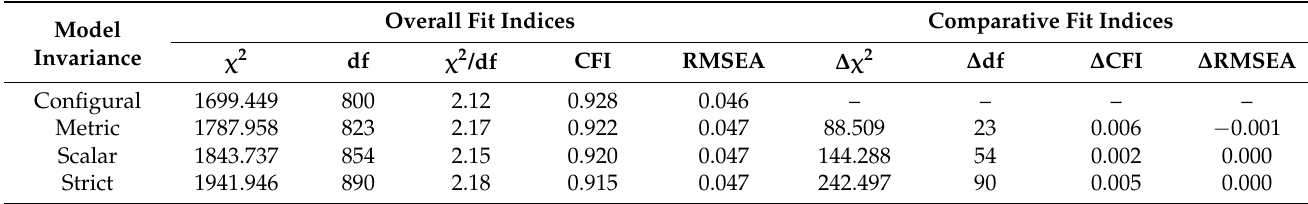
Table 4. Measurement invariance for